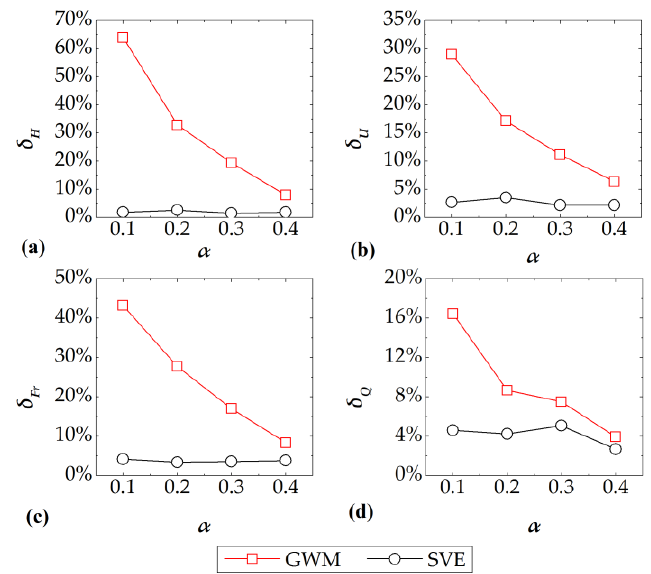
Figure 12. Error in the steady zone for different water depth ratios: ( a ) water depth; ( b ) average velocity; ( c ) Fr ; ( d ) flow discharge.